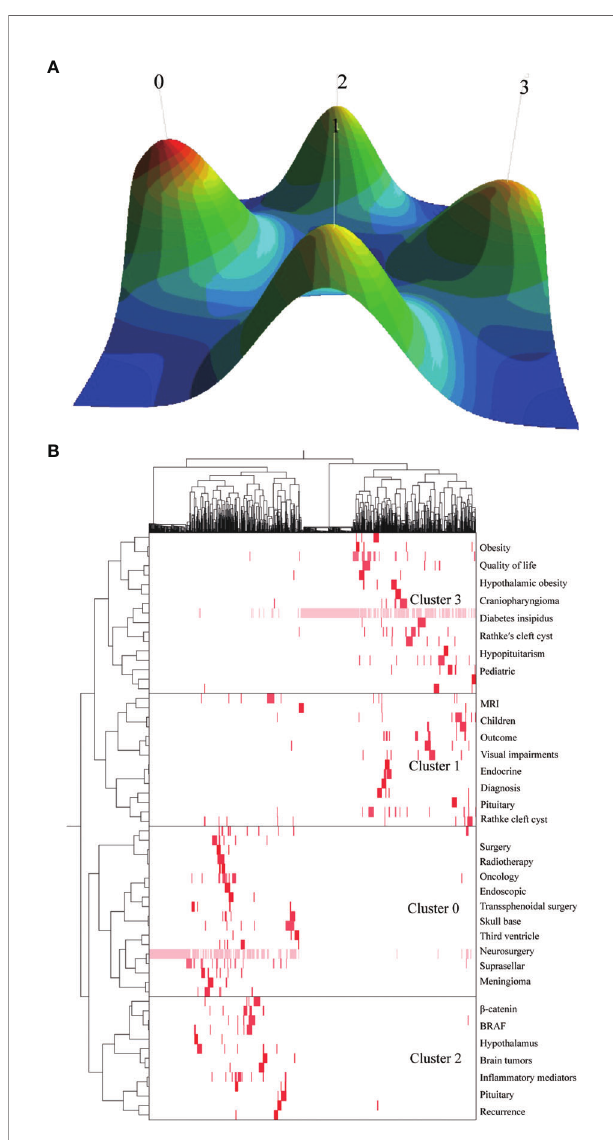
FIGURE 6 | Biclustering of highly frequent major keywords and literatures on craniopharyngioma. Mountain visualization (A) and matrix visualization (B) Conducted by gCLUTO (version1.0, University of